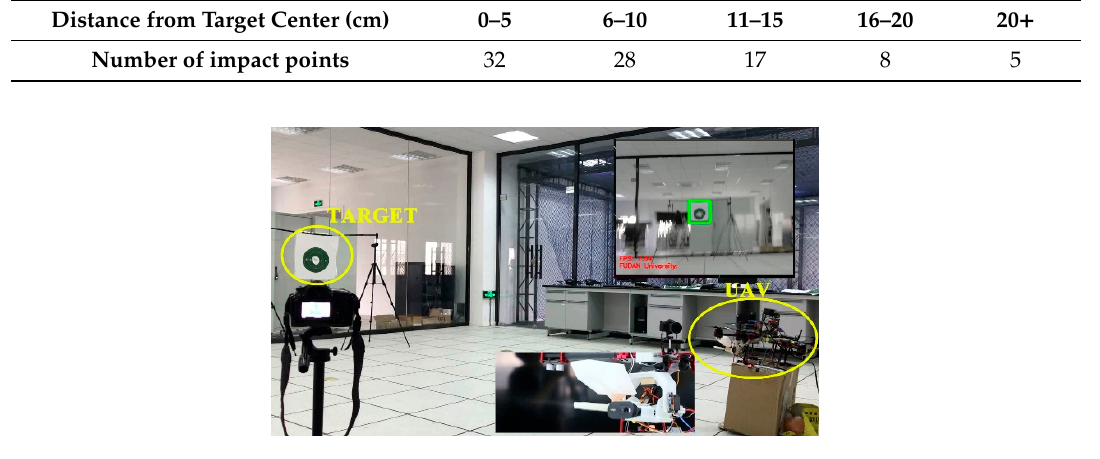
Figure 25. Indoor static test.